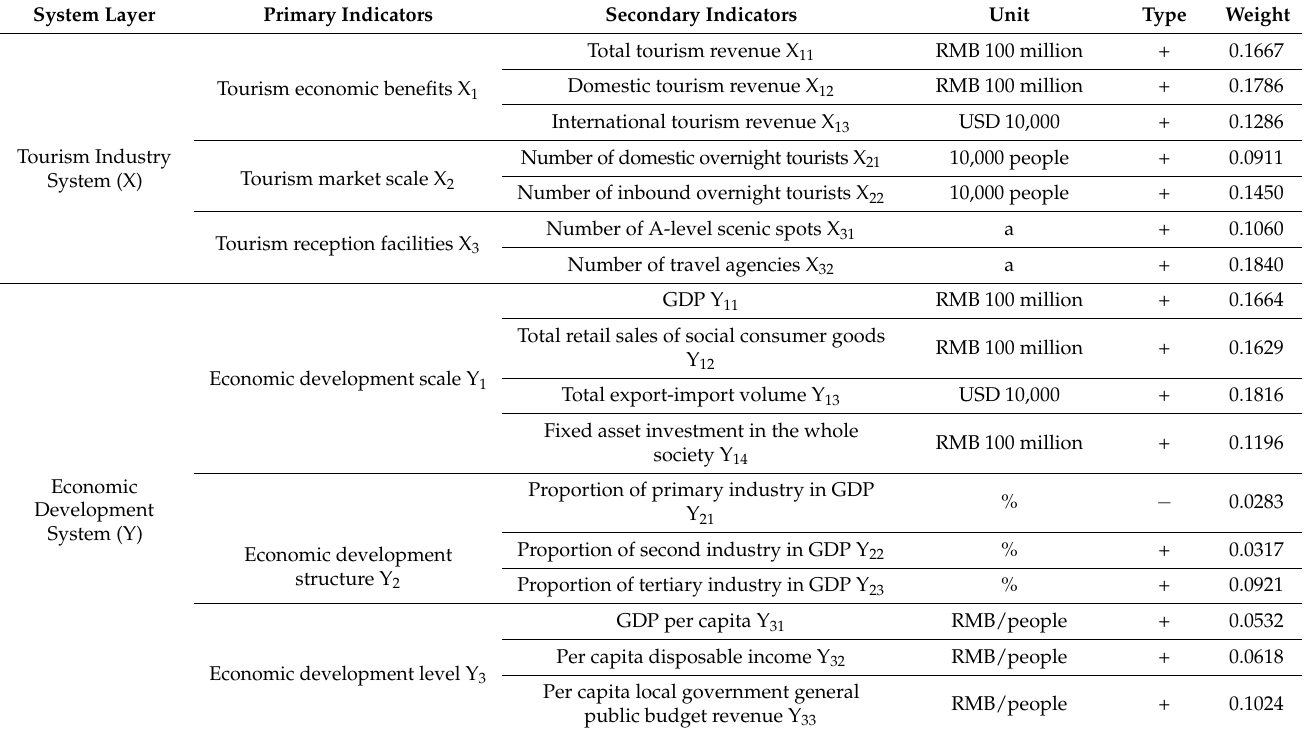
Table 1. The indicator system of three subsystems in the